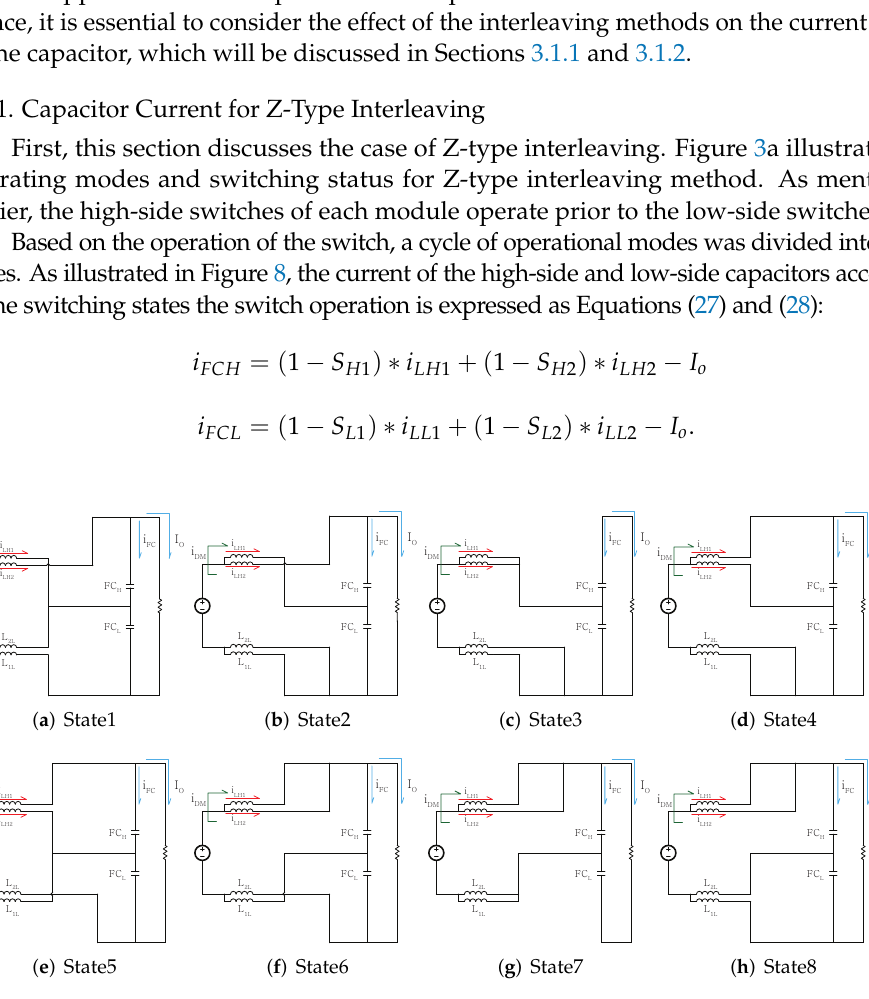
Figure 8. Operating modes and switching status for Z-type